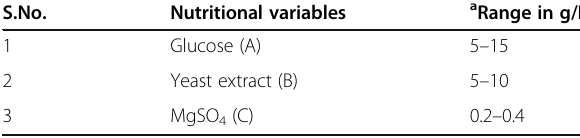
Table 4 The nutritional variables selected for optimization study S.No.